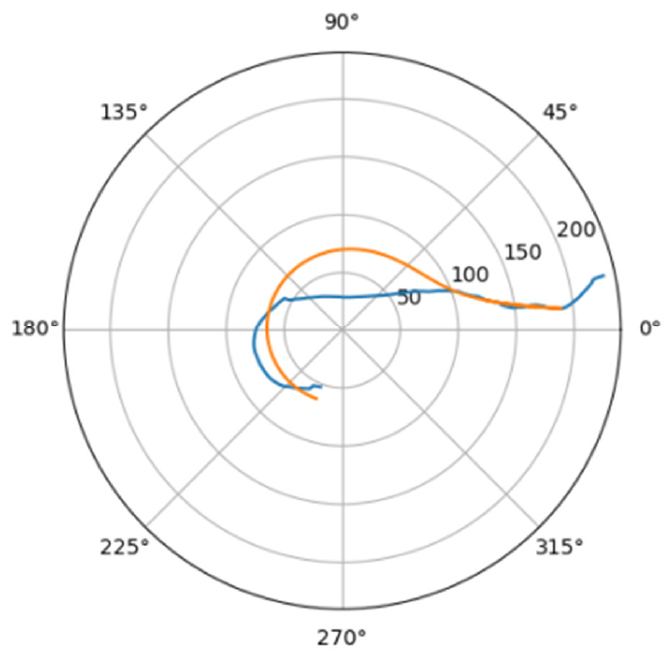
Figure 17. Approximation for mir_d.